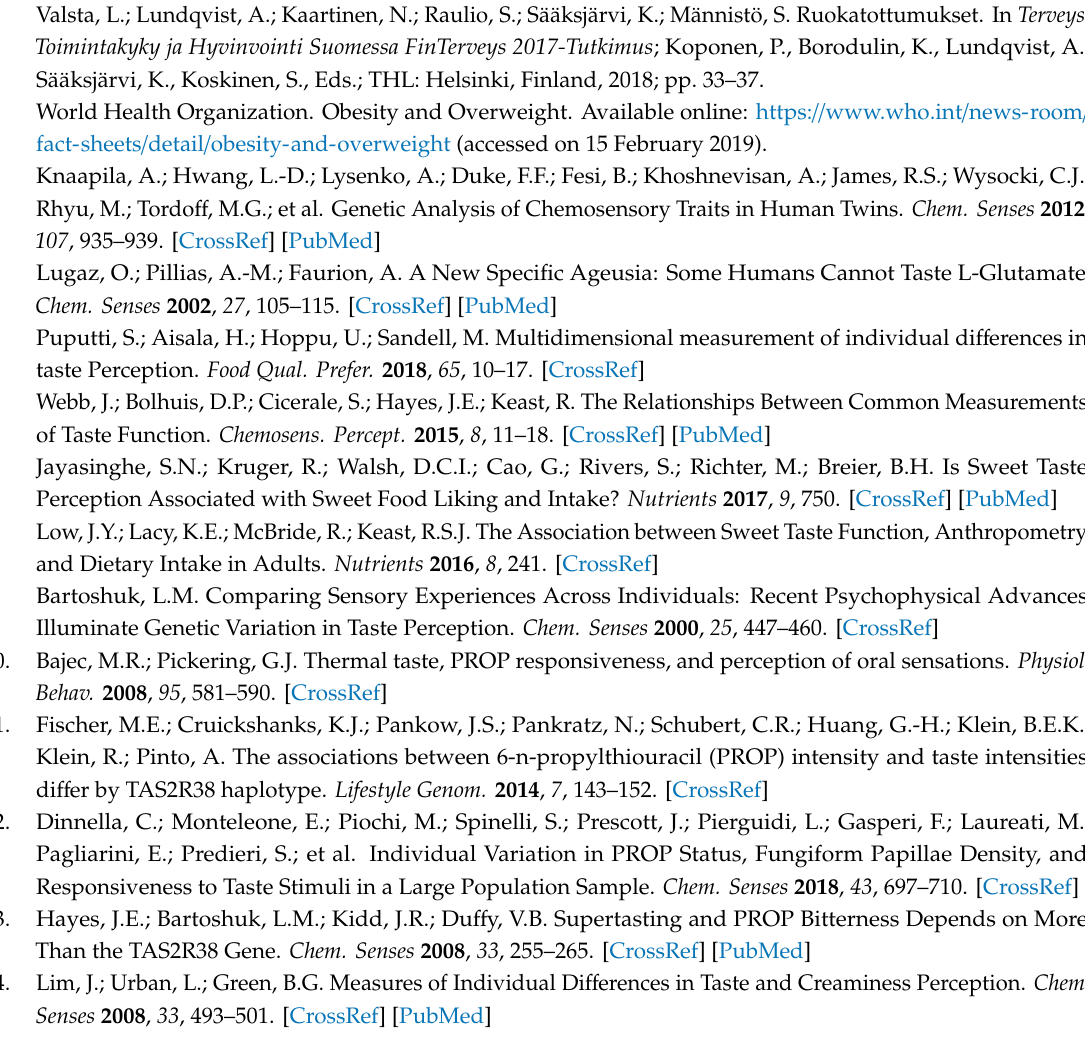
Table S1: Recalled pleasantness of all food and beverage items that were included in the factor